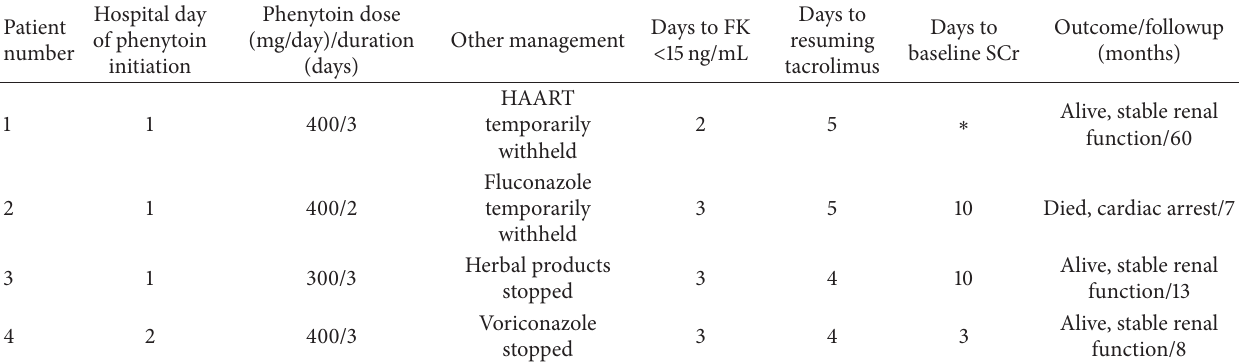
Table 2: Management of FK toxicity and